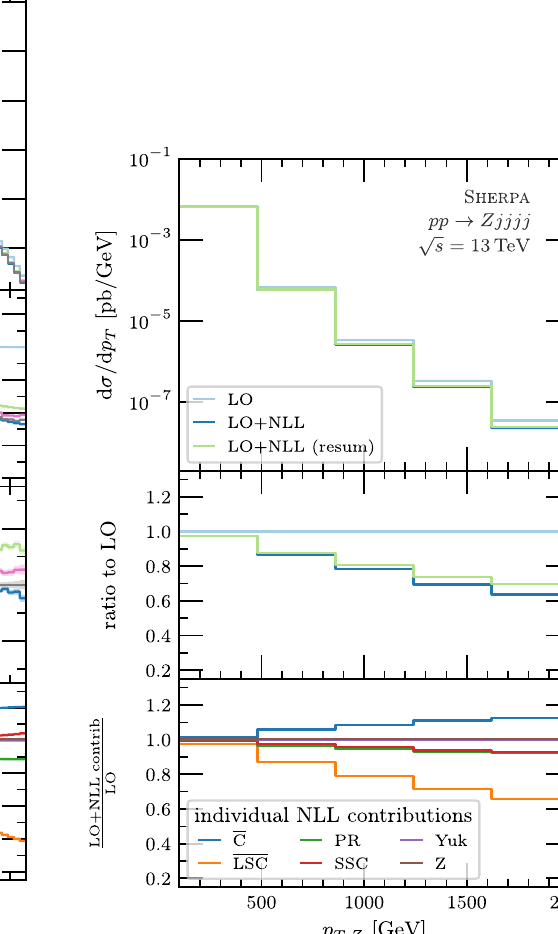
baseline calculations are compared with the results of the LO+NLL calculation, both at fixed-order and resummed. In the dijet case, the virtual approximation EW virt is shown in addition. The ratio plots show the ratios to the LO and the EW virt calculations, and the relative size of each NLL